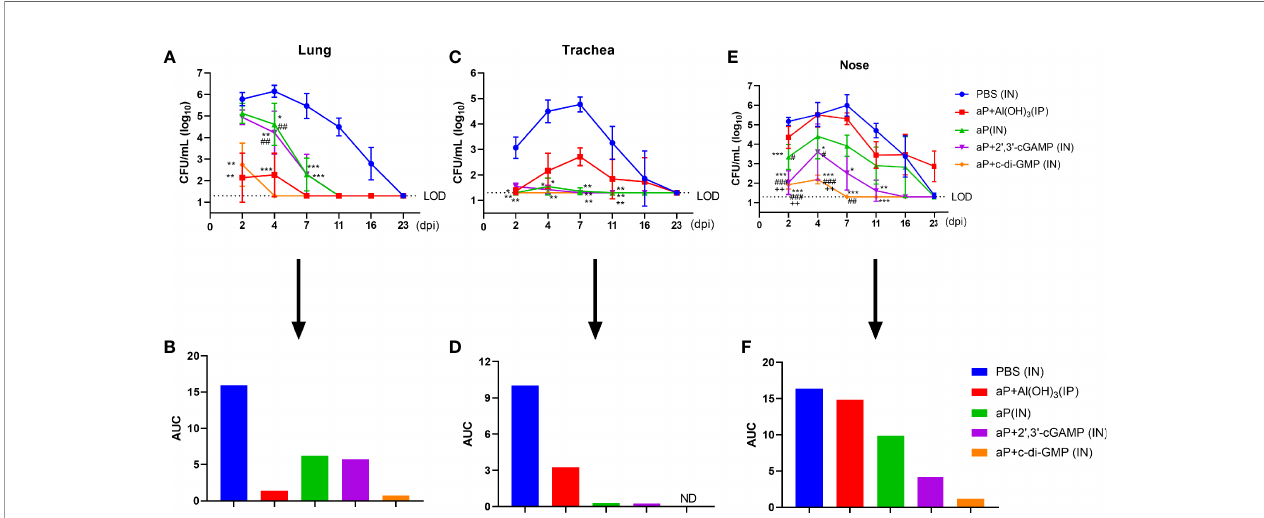
FIGURE 7 | Intranasal administration of the c-di-GMP-adjuvanted aP vaccine reduces the respiratory B. pertussis burden. Mice were intranasally administered aP vaccine alone or adjuvanted with 2 ’ ,3 ’ -cGAMP or c-di-GMP three times at three-week intervals and euthanized on day 14 after the last immunization. These groups were compared to a group that receiveda reference alum-adjuvantedaP vaccine via the intraperitoneal (IP) route three times atthree-week intervals. Mice intranasally immunized with PBS servedas the control group.Immunizedmicewere challenged byexposure to live B.pertussis three weeksafter the thirdimmunization. Analysis of bacterial burden was determined at 2, 4, 7, 11, 16, and 23 dpi. Bacteria were quanti fi ed bycounting CFU from serial dilutionsfollowing challenge. (A) CFUcounts were determined from lung homogenate. (B) The areas under the bacterial clearance curves corresponding to the curves of CFU counts fromlunghomogenate. (C) CFUcounts were determinedfromtracheal homogenate. (D) The areas under the bacterialclearance curves correspondingto the curves of CFUcounts from trachealhomogenate. (E) CFUcounts weredetermined from nasal homogenate. (F) The areas under the bacterialclearance curves correspondingto the CFUcounts from nasal homogenate. The results are the mean ± SEM (n = 5).The dashed line represents thelower limit ofdetection (LOD). ND ” indicates that noindividualsin this group had detectable levels. The P valueis indicatedas follows: * P < 0.05, ** P < 0.01, *** P < 0.001 vs. PBS-immunizedmice; # P < 0.05, ## P < 0.01, ### P < 0.001 vs. alum-adjuvanted aP vaccine-immunized mice; and ++ P < 0.01 vs. aP vaccine-immunized